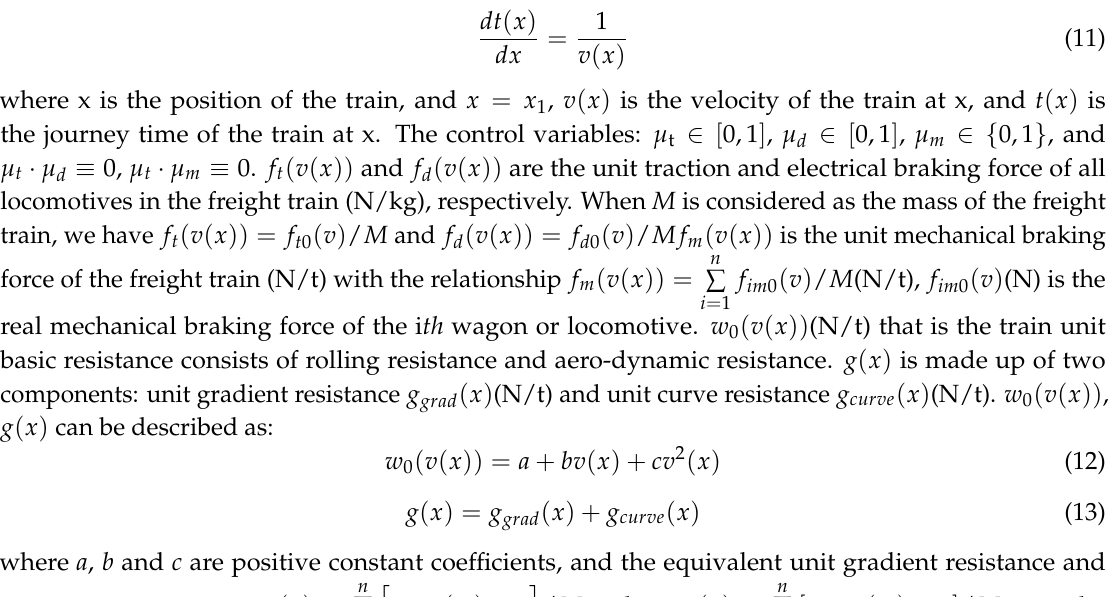
curve resistance are g grad ( x ) = mass of i th wagon or locomotive. For simplicity, there is v = v ( x )